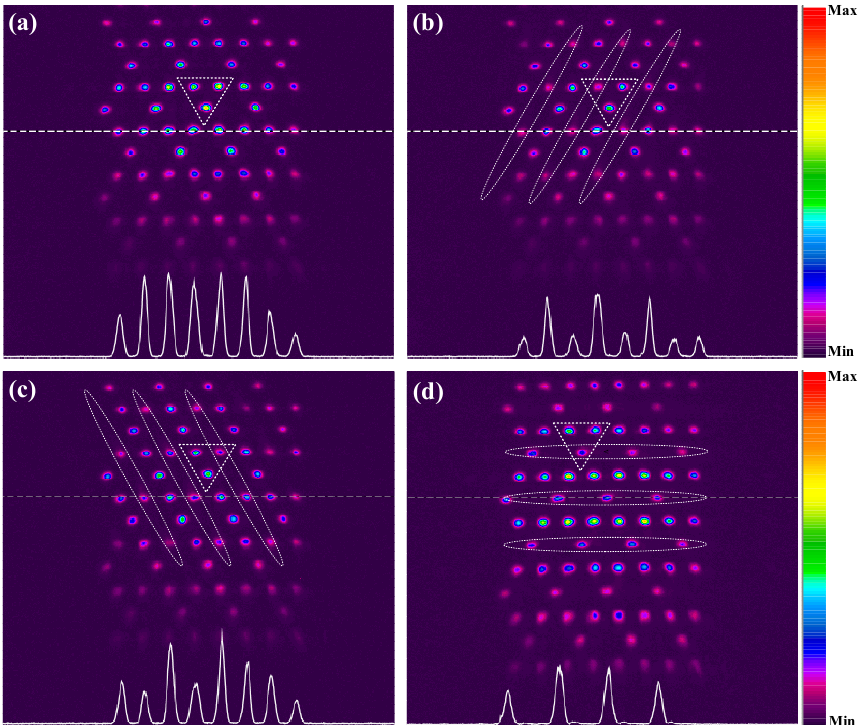
Figure 4. ( a ) Observed output probe patterns with only the Kagome coupling field on. ( b – d ) The one ‐ dimensional coupling field covers A, B, and C sublattices in the induced Kagome lattice. The dotted ellipses denote the position of the introducing coupling field E c1 and the dashed triangle in each picture represents the unit cell of the Kagome photonic lattice. The two ‐ photon detuning of two coupling fields E c1 and E c2 is fixed at δ c1 = ∆ p − ∆ c1 = − 10 MHz and δ c2 = ∆ p − ∆ c1 = 10 MHz, respectively, with ∆ p = 100 MHz. The power of the probe field is P p = 1 mW, and the power of the coupling fields E c1 and E c2 are P c1 = 20 mW and P c2 = 10 mW, respectively. The change in the unit cell (the dashed triangle in each panel in Figure 4) of the Kagome photonic lattice indicates the modulation of the band structure. For the case of without modulation, the three sublattices in the unit cell have the same intensity, as shown in Figure 4a. After introducing the coupling field E c1 (whose location is marked by dotted ellipses) to cover each set of sublattices, the refractive index as well as the band structure will be modulated accordingly. As a result, it can be seen that the inten ‐ sity of the covered sublattice in the unit cell is weakened. The white curve at the bottom of each picture in Figure 4 shows the intensity of the region marked by a dashed line. This white dashed line and the intensity curve come from the software of the CCD cam ‐ era itself. According to Equation (1), the structured Rabi frequency is a critical parameter that determines the spatial refractive index distribution and is directly related to the power of laser beams. A benefit from the easily accessible tunability of the electromagnetically induced optical lattices is that we can explore the dynamics of light that reflects the vari ‐ ation of the band structure by adjusting the laser power [52]. As such, we demonstrate the modulation effect of the introduced coupling field E c2 on the band structure by ad ‐ justing its power. Firstly, we fix the power of the Kagome ‐ lattice coupling field E c1 at 20 mW, which allows us to observe a Kagome pattern [Figure 5a] with high contrast at the output plane of the cell. Then, we increase the power of E c2 to 10 mW gradually, and the evolution of the output probe is shown in Figure 5b–f. The coupling field E c2 (denoted by